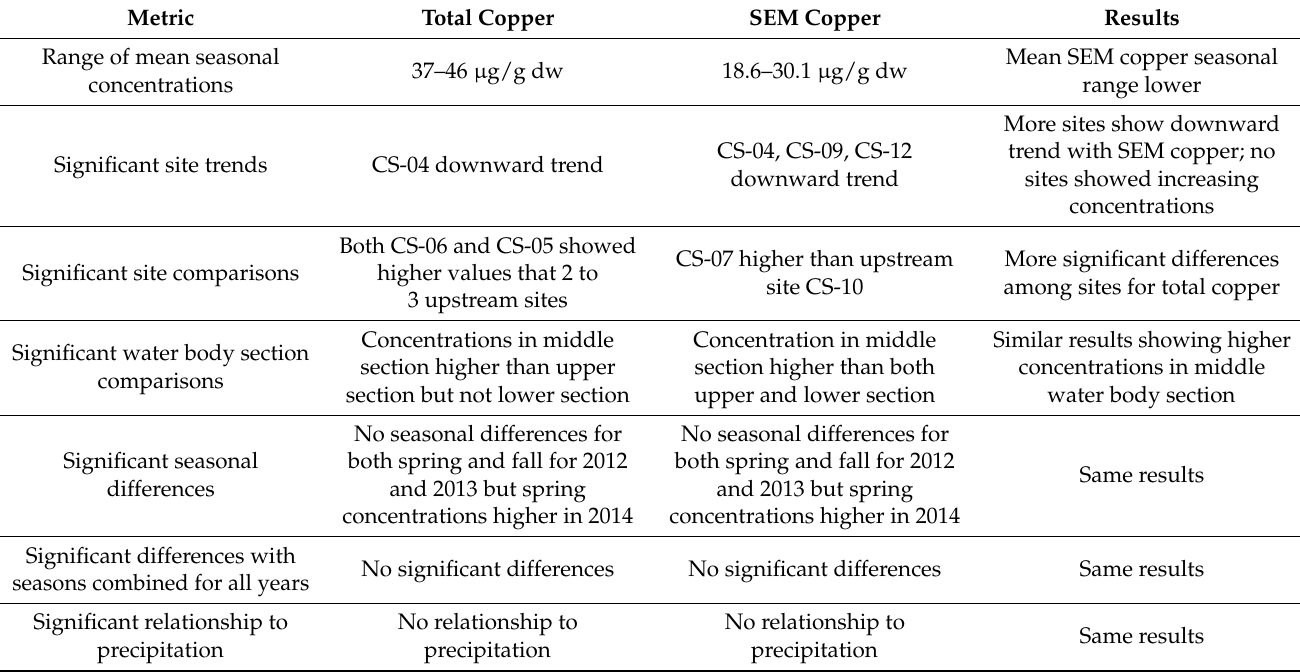
Table 5. Comparison of total copper and SEM copper metrics in Cache Slough